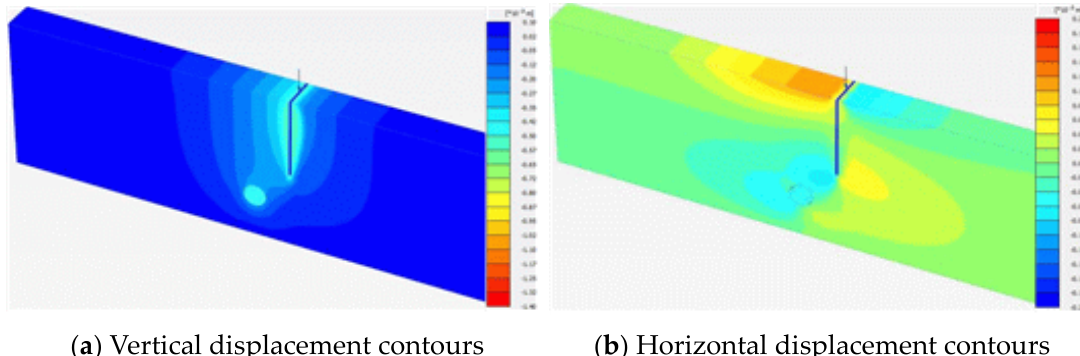
Figure 20. Displacement contours for allowable load (case 1-1).